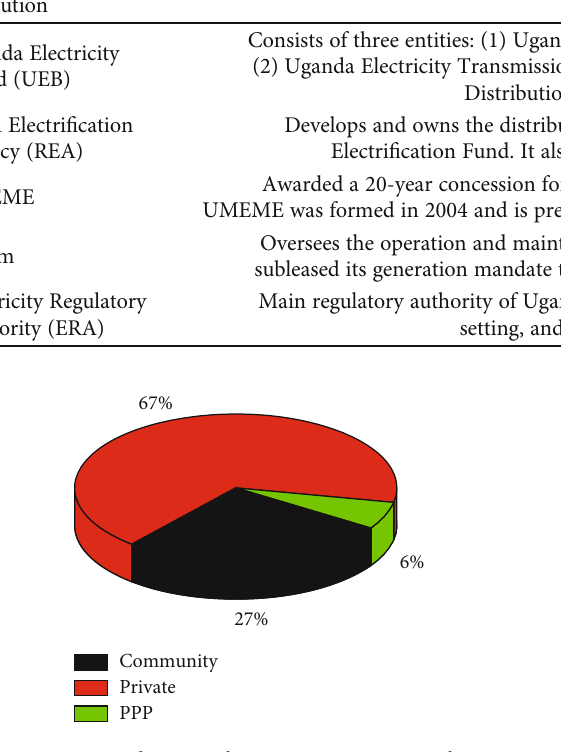
Figure 6: Minigrid ownership options in Uganda. Source: Bloomberg NEF, developers.